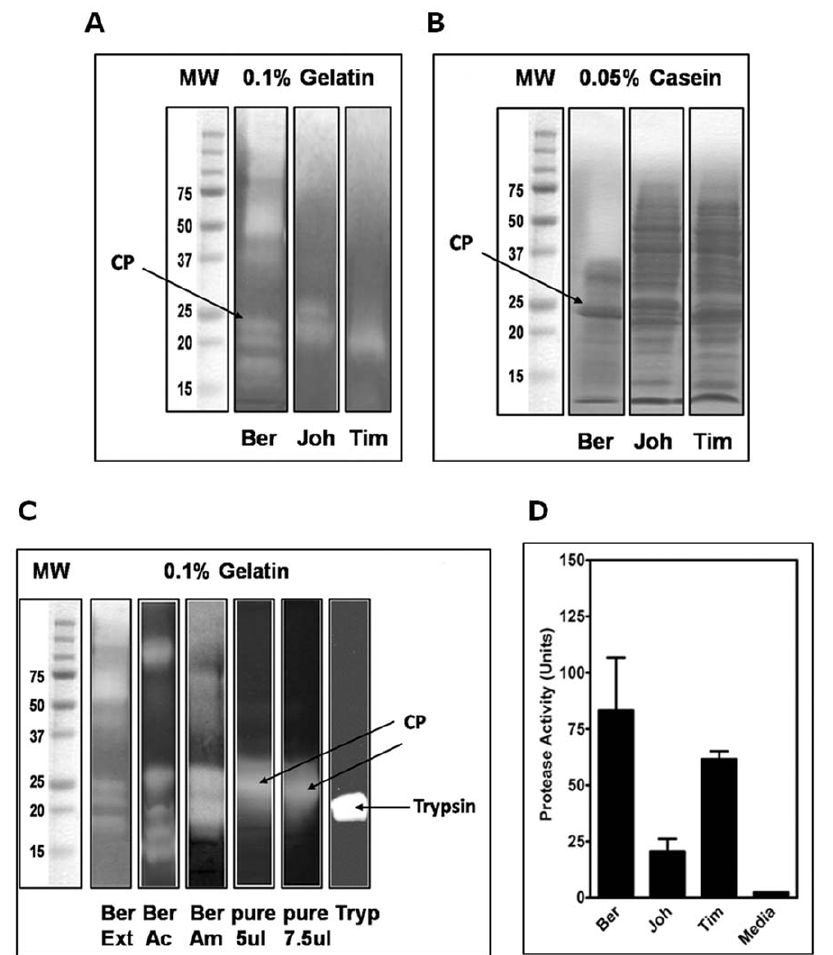
Figure 5. Total proteinase activity of pollen coat proteins from Bermuda, Timothy, and Johnson grass assessed by gelatin and casein zymography. Bands with proteinase activity were visualized as white clear or light lytic zones against a dark background of Coomassie-blue- stained gel ( A, gelatin ) and ( B, casein ). On the left, molecular mass markers in kDa are indicated. ( C ) Pollen coat proteins from Bermuda grass. MW markers were on the left lane, and crude extracts (Ext), concentrated with 80% Acetone (Ac) and with 70% ammonium sulfate (Am), pure cysteine protease (pure, 5 and 7.5 m g/lane) and trypsin as a positive control are shown. The gelatin zymography gives a representative image from 4 separate studies that yielded similar results. ( D ) Protease activities in pollen surface proteins from Bermuda, Johnson, and Timothy grass corresponding to the lanes in (A) and (B) in the upper panels. The protease activities of pollen surface proteins, equalized for protein concentration, were examined for proteinase activity by use of a chromogenic substrate. The activity was recorded and expressed as units of enzyme activity per milligram of total protein. The cysteine protease colorimetric assay shows significantly greater proteinase activity in the proteins extracted from the Bermuda grass pollen surface compared with proteins extracted from Johnson grass or Timothy grass pollen surface. Bars represent the mean of proteinase activity units of four replicates.